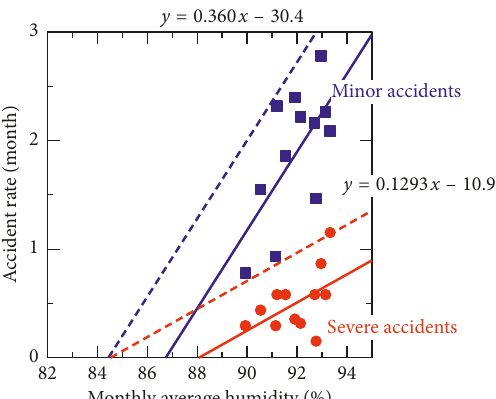
Figure 7: Relationship between accidents rate and monthly average humidity levels by data logger #2. Broken lines are the upper limits of the 95% confidence of the regression